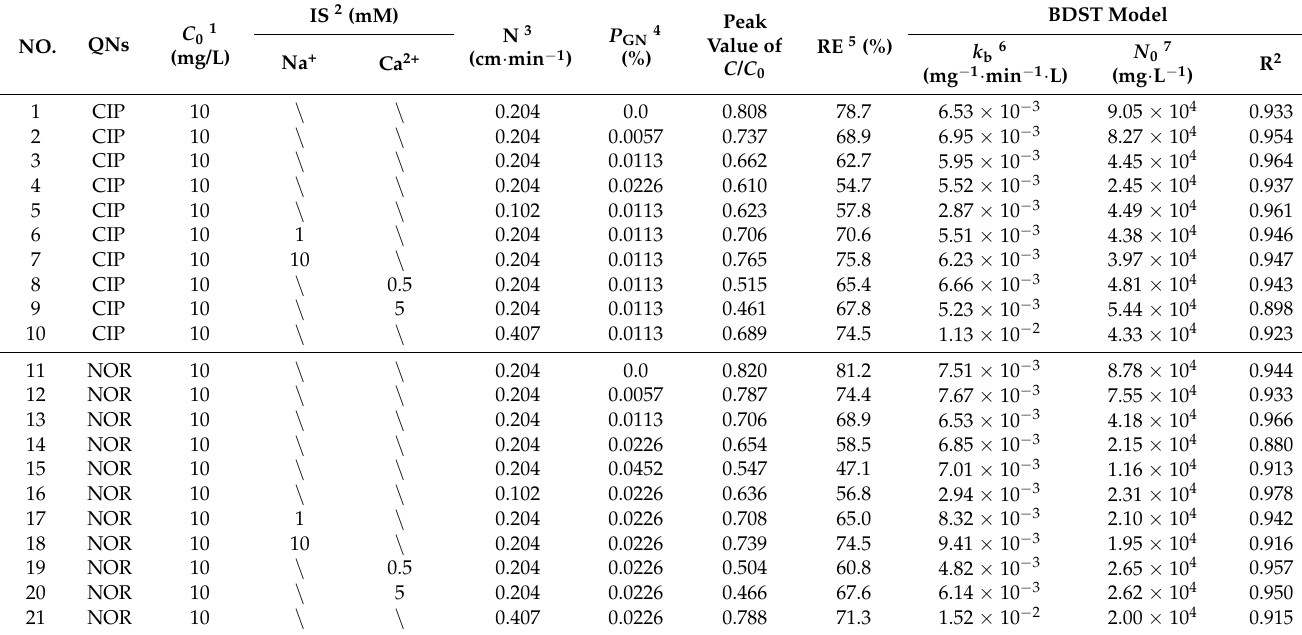
Figure 1. Column experimental system. Table 1. Experimental conditions and model